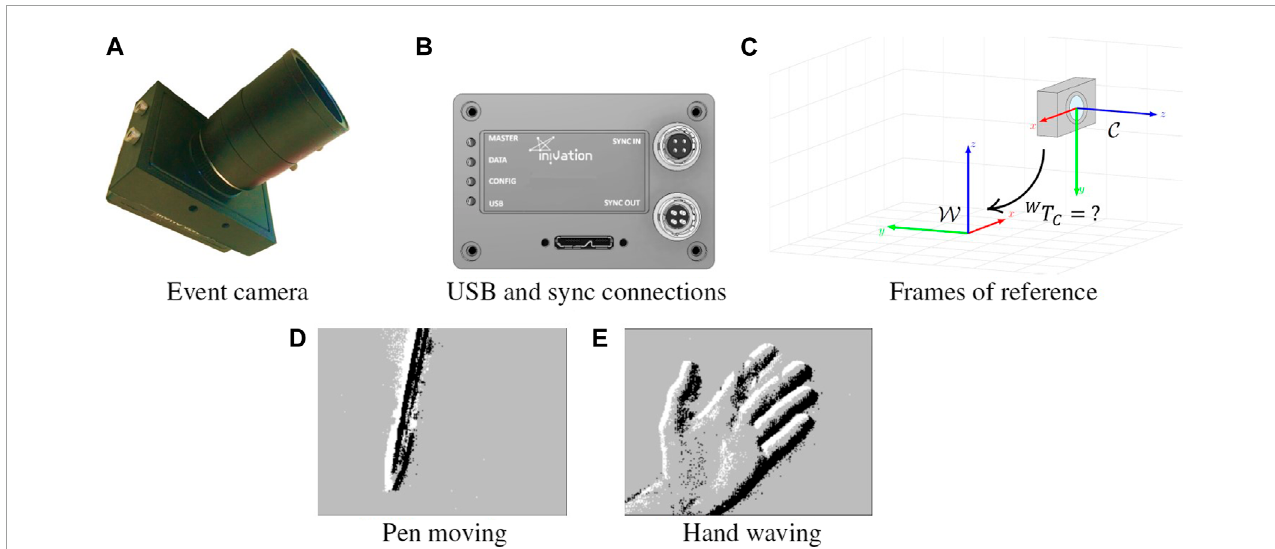
FIGURE 1 (A) iniVation DVS240 event camera, (B) the available connectors, (C) relevant coordinate frames, namely world frame W and camera frame C . Outputs of event cameras, pen moving in front of the camera (D) and a person’s hand waving in front of the camera (E) . White and black denote the polarity of the event being represented, in particular positive and negative,